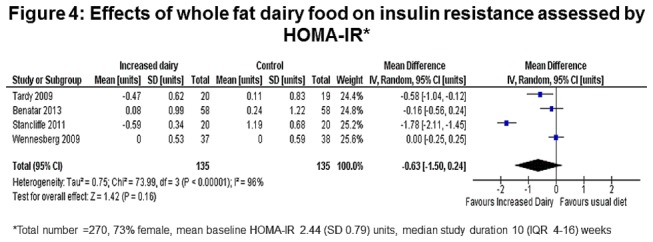
Effects of whole & low fat dairy food on Insulin resistance as measured by HOMA-insulin resistance.